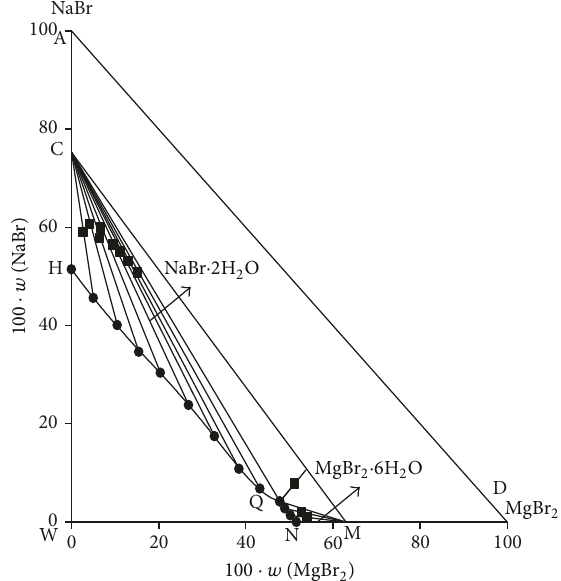
Figure 3: Equilibrium phase diagram of the ternary system NaBr + MgBr 2 + H 2 O at 313.15 K. e , equilibrium liquid phase composition; ◼ , moist solid phase composition; A, pure solid of NaBr; D, pure solid of MgBr 2 ; C, pure solid of NaBr ⋅ 2H 2 O; M, pure solid of MgBr 2 ⋅ 6H 2 O; W, water; H, solubility of NaBr in water; N, solubility of MgBr 2 in water; Q, cosaturated point of MgBr 2 ⋅ 6H 2 O and NaBr ⋅ 2H 2